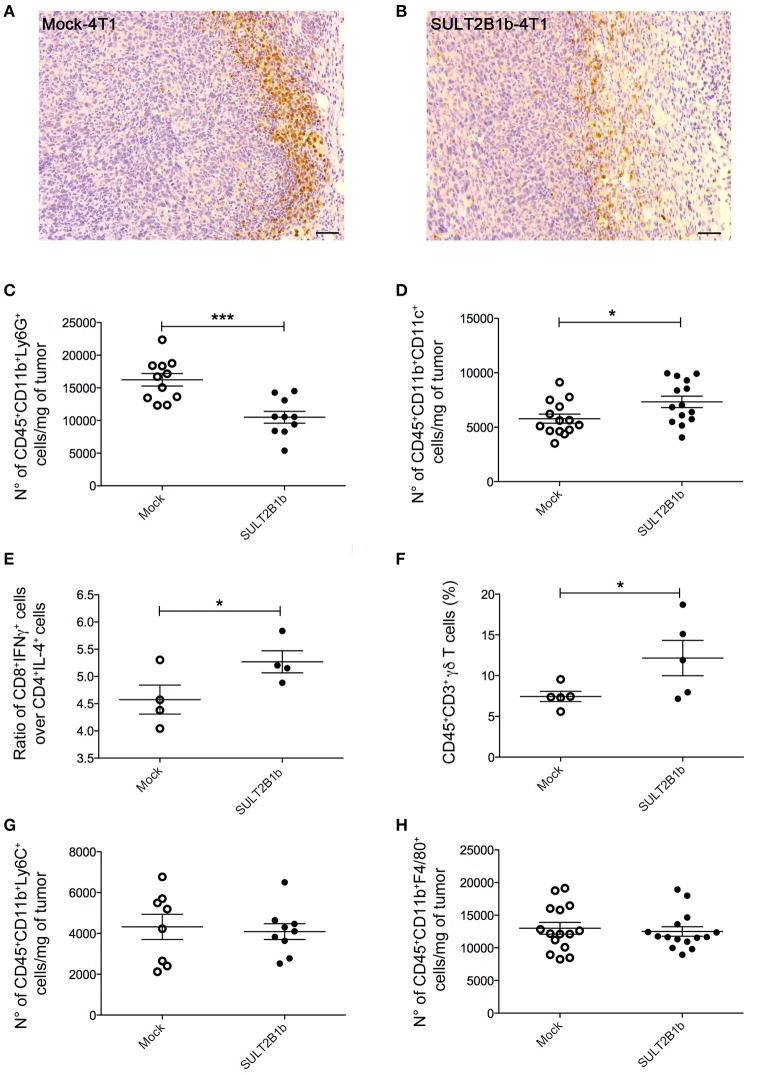
TME modifications in the presence of SULT2B1b-4T1 tumors. (A,B) Tumor-host interface of Mock-4T1 (A) and SULT2B1b-4T1 (B) primary breast tumors immunostained with anti-Ly6G mAb. A reduced density of Ly6G+ neutrophils is visible in SULT2B1b-4T1 tumors (B). Original magnification 200x; bar, 100 μm. (C,D) Quantification of neutrophils (C) and dendritic cells (D) by flow cytometry analysis of Mock-4T1 and SULT2B1b-4T1 tumors after mechanical and enzymatic digestion. Enumeration was expressed as the number of cells/mg of tumor tissue. (E) Ratio between CD8+IFNγ+ and CD4+IL4+ T cells. (F) Percentage of CD3+ γδ+ T cells. (G,H) Quantification of the CD11b+Ly6C+
(G) and CD11b+F4/80+
(H) cells by flow cytometry analysis of Mock-4T1 and SULT2B1b-4T1 tumors after mechanical and enzymatic digestion Enumeration was expressed as the number of cells/mg of tumor tissue. *p < 0.05. ***p < 0.001 (Student's t-test).